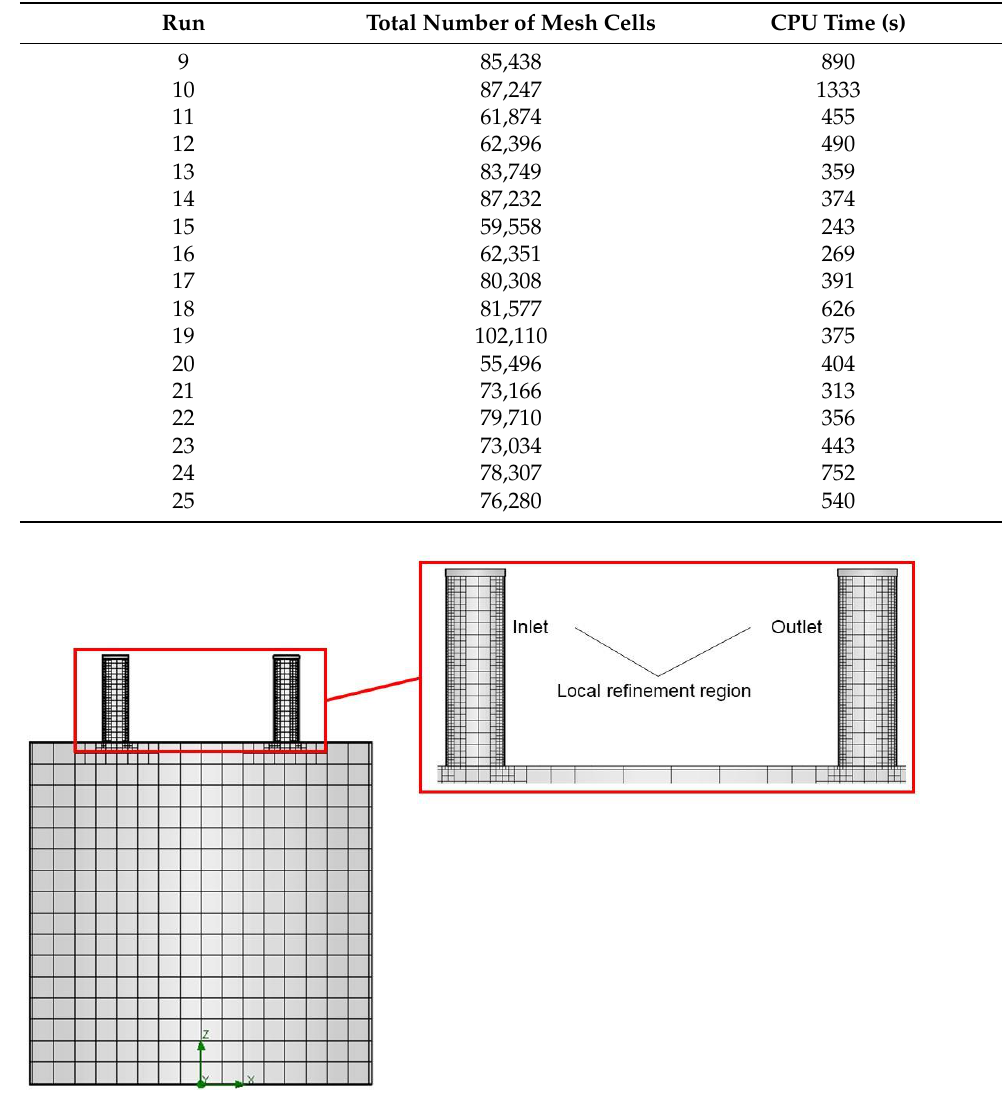
Figure 13. Air velocity in reaction cell and current lines, in run 1, for the geometry with lateral air inlet and outlet. Q = 1.5 L/min; Di RC 6.0 cm; D I = 2.5 cm; D O = 2.5 cm.